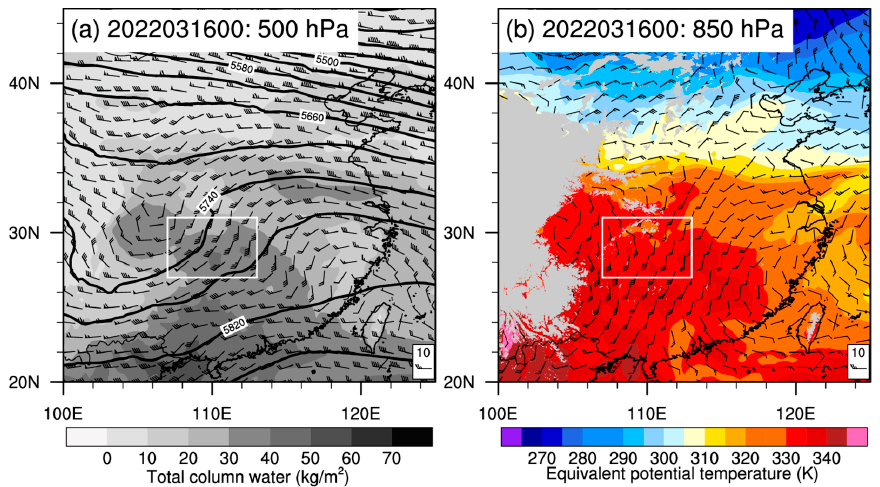
Figure 2. The ERA5 data for ( a ) 500 hPa geopotential height (solid black, contoured every 30 m) and wind barbs (m/s) superimposed on total column water (kg/m 2 ; grayscale shading) and ( b ) 850 hPa equivalent potential temperature (K; color shading) and wind barbs (m/s) at 0000 UTC on 16 March 2022. The gray shading in ( b ) denotes terrain height > 1.5 km. The white rectangles in ( a , b ) represent the area of the squall line system.